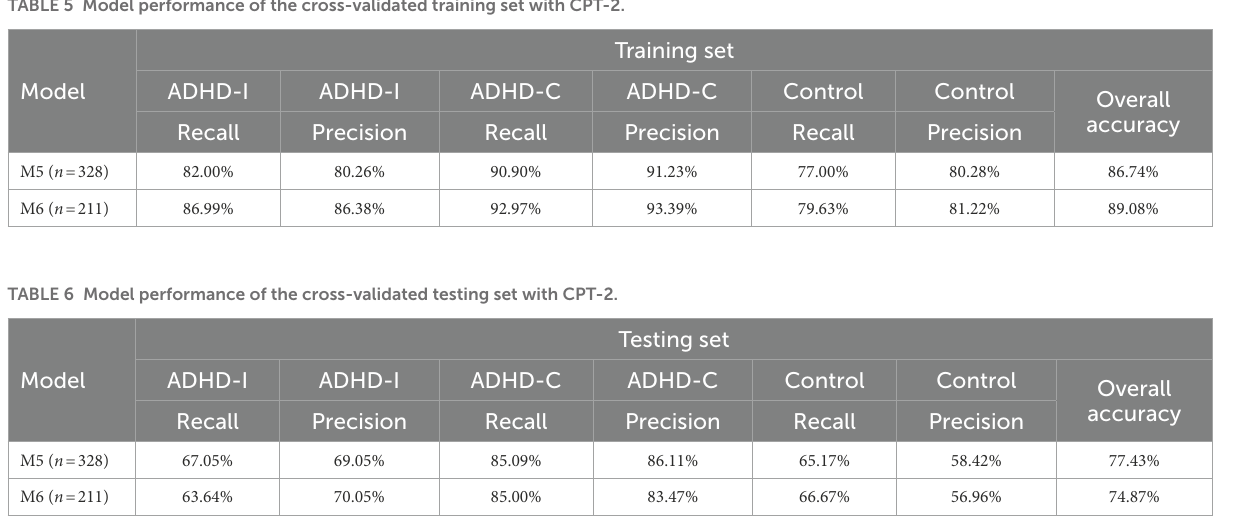
TABLE 5 Model performance of the cross-validated training set with CPT-2.